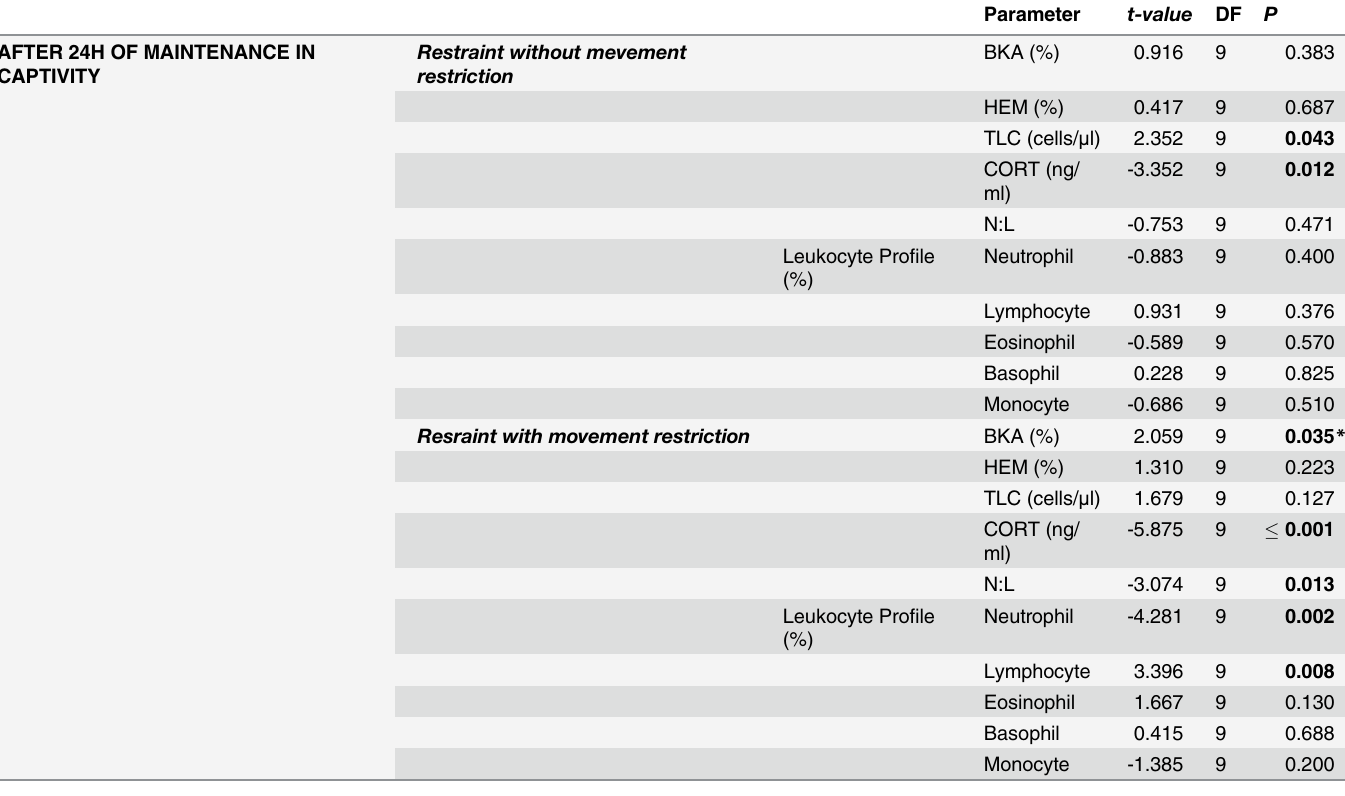
Paired samples T-Test. Tests signi fi cant at 0.05 are in